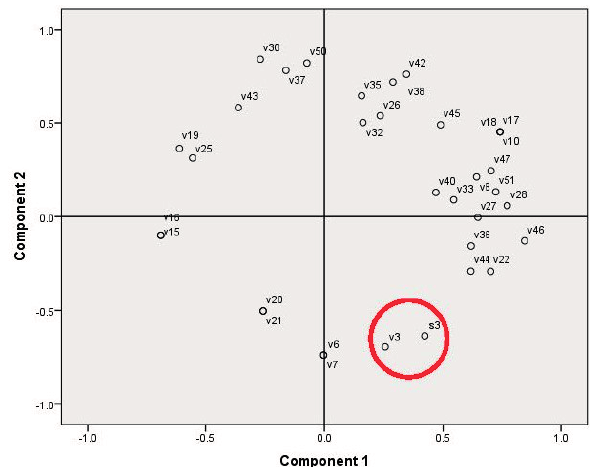
Figure 4. PCA on the cell line proliferation inhibition and concentration of moss secondary metabolites (area marked with red circle: the human lung carcinoma proliferation data (S3) and substance numbers (v1–v53) according to Table 5 were used as